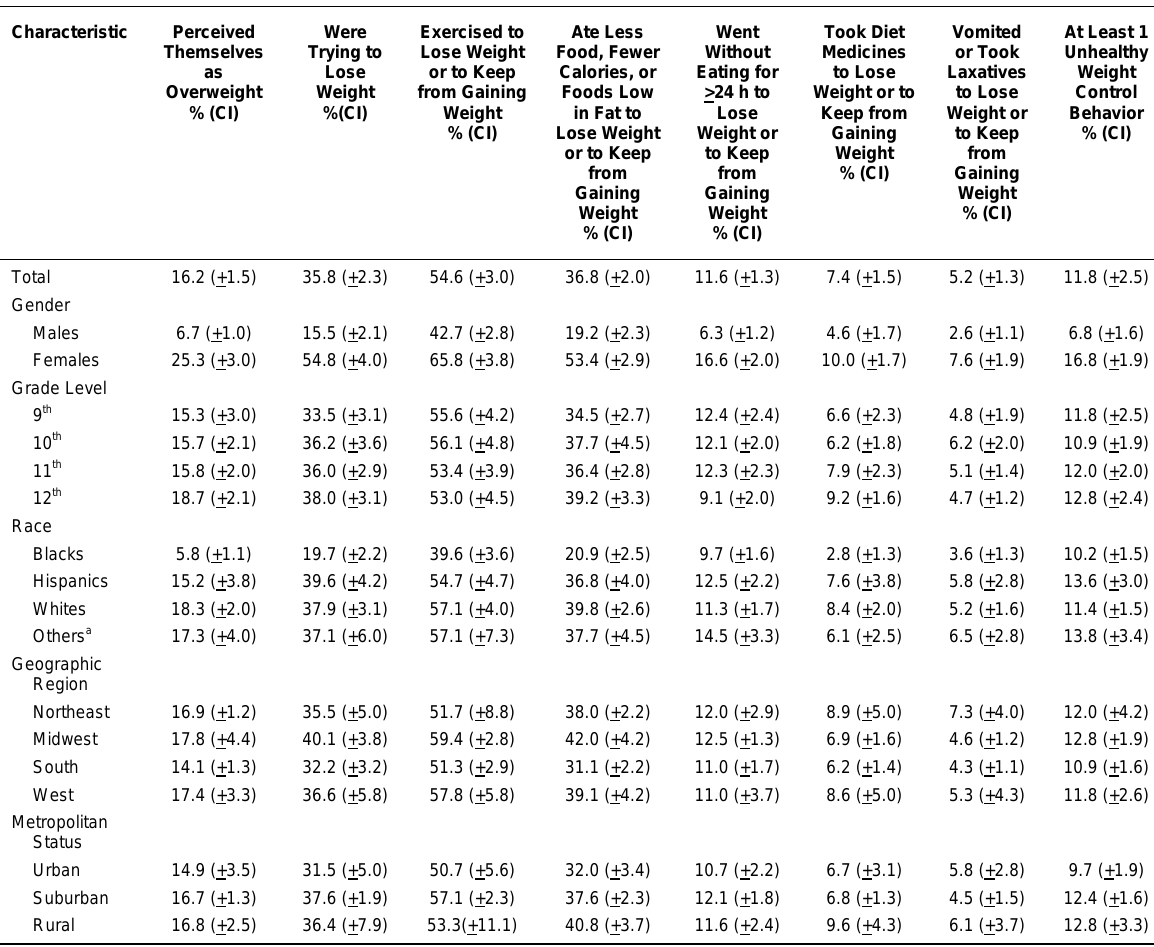
Prevalence of Overweight Misperception and Weight Control Behaviors by Sociodemographic and Geographic Characteristics, YRBS